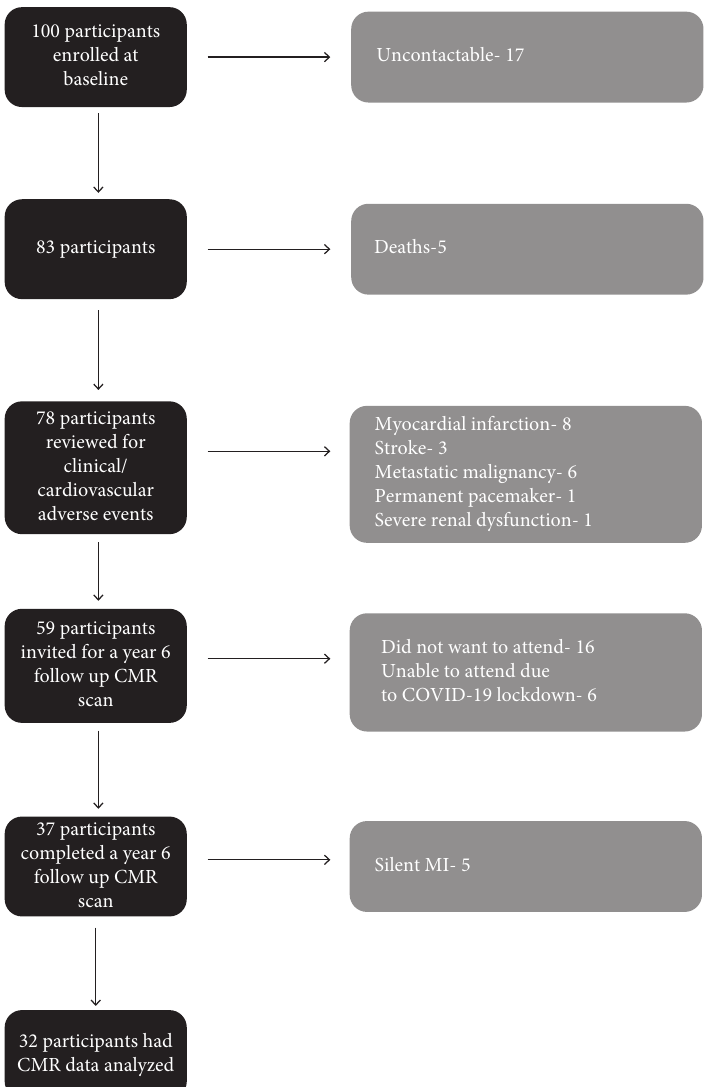
Figure 2: Recruitment flowchart. Recruitment flowchart demonstrating recruitment and follow-up pathway for the participants (CMR- cardiac magnetic resonance; COVID-19-coronavirus disease; MI-myocardial